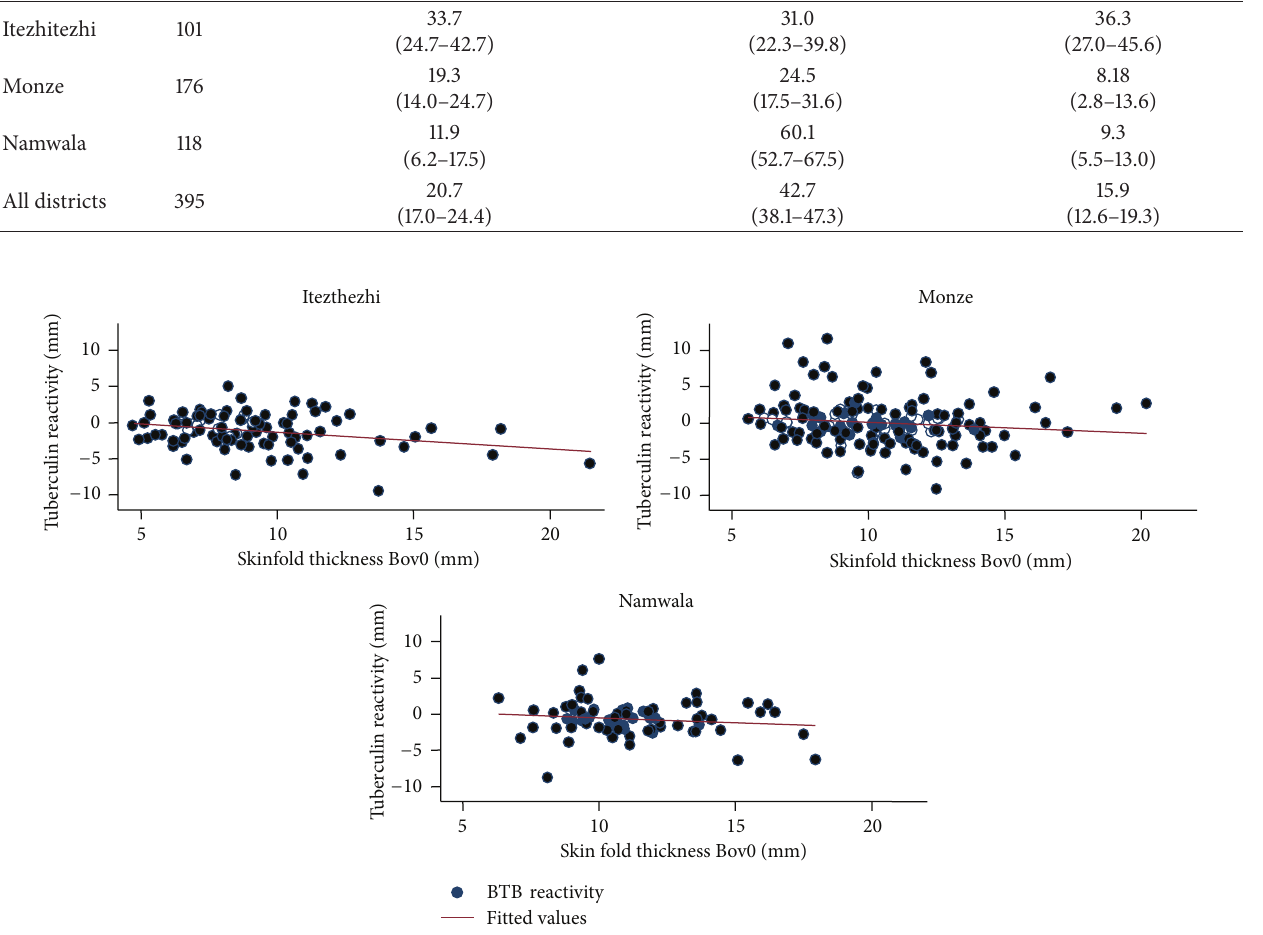
Figure 2: Scatterplot and regression line showing the relationship between BTB reactivity (( Bov 72 − Bov 0) − ( Av 72 − Av 0)) and intial skinfold thickness at bovine site (Bov0) by District (Itezhitezhi, 𝑛 = 102 ; Monze, 𝑛 = 176 ; Namwala, 𝑛 = 181 ) where reduced BTB reactivity was observed with increasing skinfold thickness. Skin fold thickness at the bovine site was negatively correlateded with tuberculin